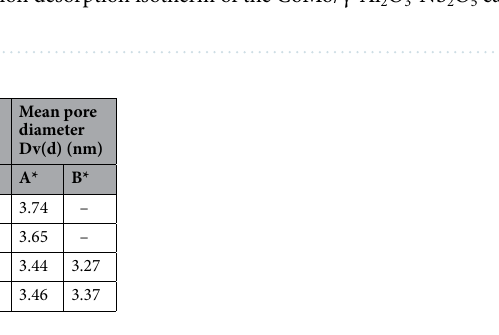
Table 1. Textural properties of the support and catalysts. *A—samples before sulphidation. *B—samples after sulphidation.